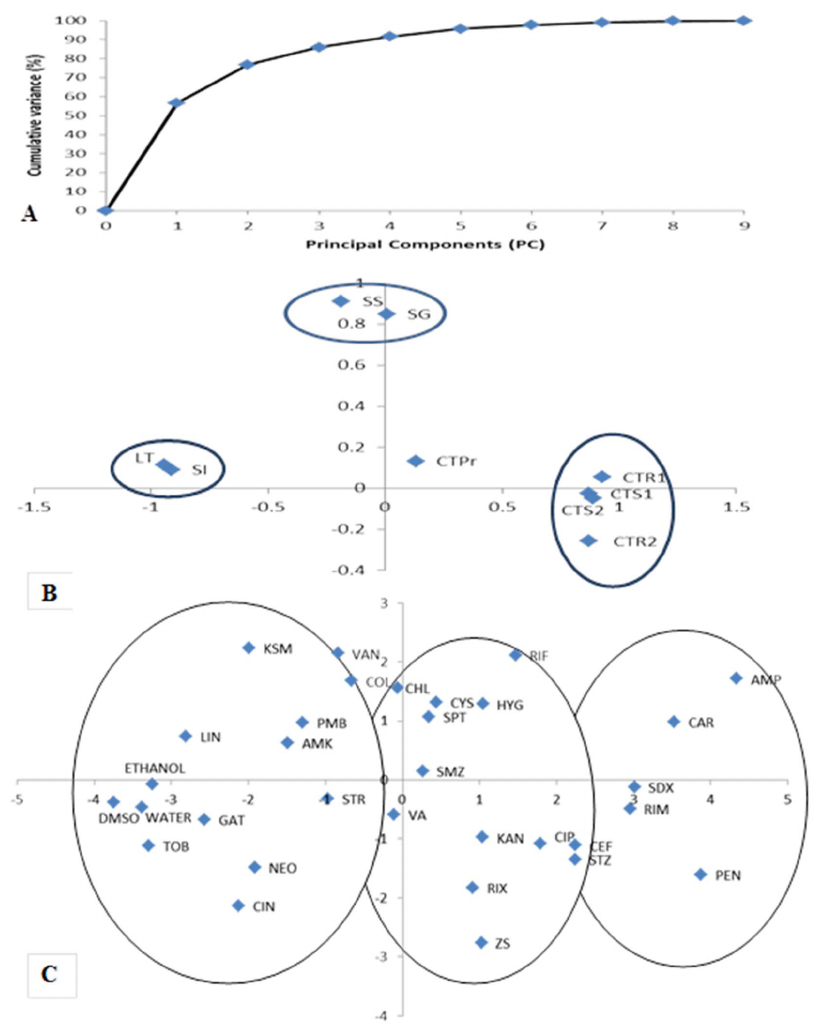
Figure 2. Principal component analysis (PCA) plots. A) Cumulative variance; B) Loading plots for different variables on PC 1 (antibacterial activity) and PC 2 (phytotoxicity). CTPr: Ct before treatment of infected scion; CTS-1 and CTR-1: Ct value in the scion and rootstock of the graft- inoculated at DAT 120, respectively; CTS-2 and CTR-2: Ct value in the scion and rootstock of the graft-inoculated at DAT 180, respectively; SI36 and LT36: Scion infection percentage (SI) and Las transmission rate (LT) were calculated when Ct value was cut off at 36.0, respectively; SS and SG: Scion survival and scion growth, respectively; C) PCA scores plot for different antibiotics on PC 1 (antibacterial activity) and PC 2 (phytotoxicity). data on the percentage of scion infection (SI) and Las transmission (LT) but with opposite values. The scion survival (SS) and growth percentages (SG) contributed primarily to PC 2 . The Ct values of pre-treated scions (CTPr) contributed almost equally to PC1 and to PC2 (Fig. 2B). A number of observations were made from the antibiotic score plot for PC 1 versus PC 2 (Fig. 2C). Firstly, 16 antibiotics, such as AMP, CAR, PEN, SDX and RIM, were located in the right quadrants while the other antibiotics and controls (water, DMSO and ethanol) were situated in the left quadrants. Secondly, 14 antibiotics, such as AMP, CAR and VAN, were located on the upper quadrants of the plot while the other 15 antibiotics and 3 controls were located in the lower quadrants. The antibiotics in the right quadrants, e.g. , AMP, CAR, PEN, SDX and RIM, were effective in eliminating or suppressing Las, while antibiotics on the upper quadrants, e.g. AMP, CAR and VAN, were less phytotoxic to citrus.